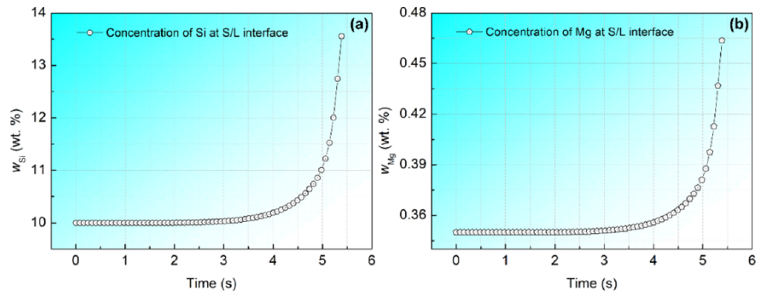
Figure 5. Solute concentration at S/L interface evolves with solidification time: ( a ) Si solute concen ‐ tration; ( b ) Mg solute concentration.